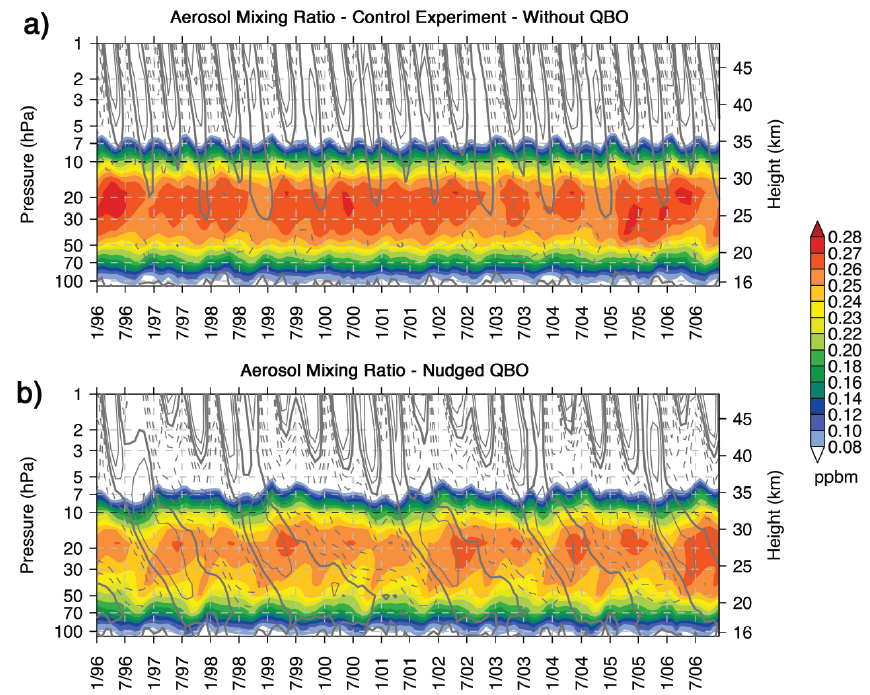
Figure 3. Temporal evolution of the monthly mean zonal mean aerosol mass mixing ratio ( × 10 9 kg(S)kg − 1 ) in (a) the CTL simulation of Hommel et al. (2011) and (b) the QBO-nudged model between 5 ◦ N and 5 ◦ S for the years 1996–2006. Grey contours denote the zonal wind as in Fig. 1, where dashed lines represent easterlies.